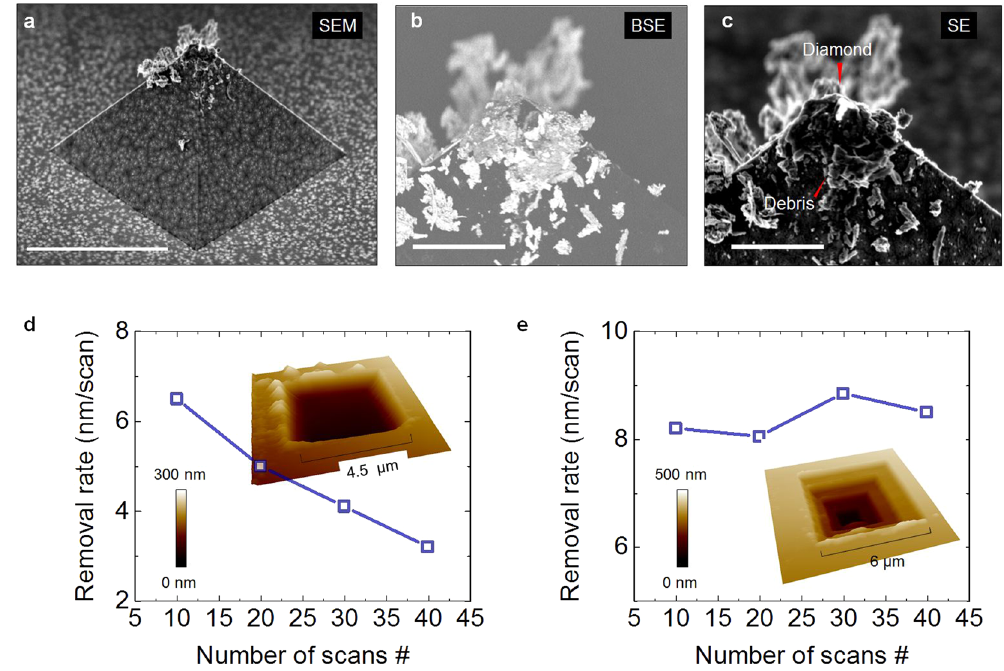
Figure 6. Impact of the tip-apex contamination and material re-deposition. ( a ) SEM image of the diamond tip after usage (scale bar 5 µ m). ( b ) Zoom-in image by SEM back-scattered electrons (scale bars 1 µ m) and ( c ) secondary electrons. Thanks to the high secondary-electron emission for diamond, the area of the tip-apex used in contact with the sample is clearly revealed. ( d ) Apparent decrease in the RR induced by the re-deposition of material in the worn area. ( e ) This artifact can be removed by a progressive reduction of the scan area during the removal which guarantees a more stable